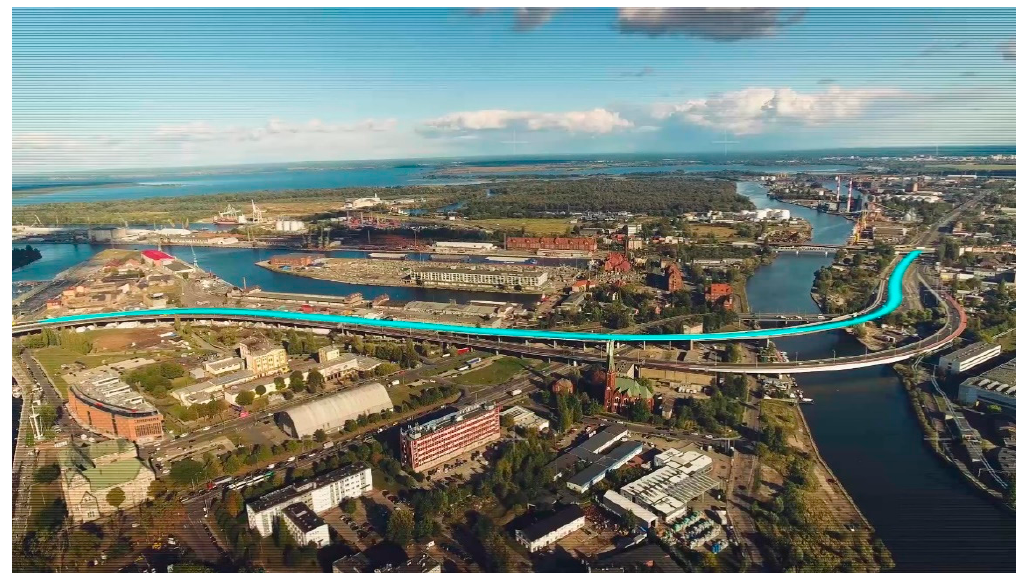
Figure 11. View on a part of the Trasa Zamkowa arterial thoroughfare—city bound road.